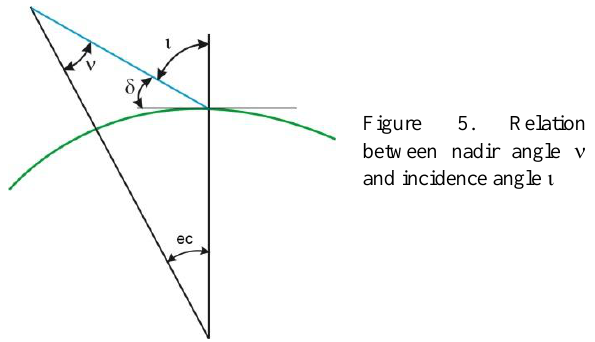
Figure 7. Theoretical collection capacity for panchromatic images, for panchromatic plus color channels the capacity is reduced by factor 2